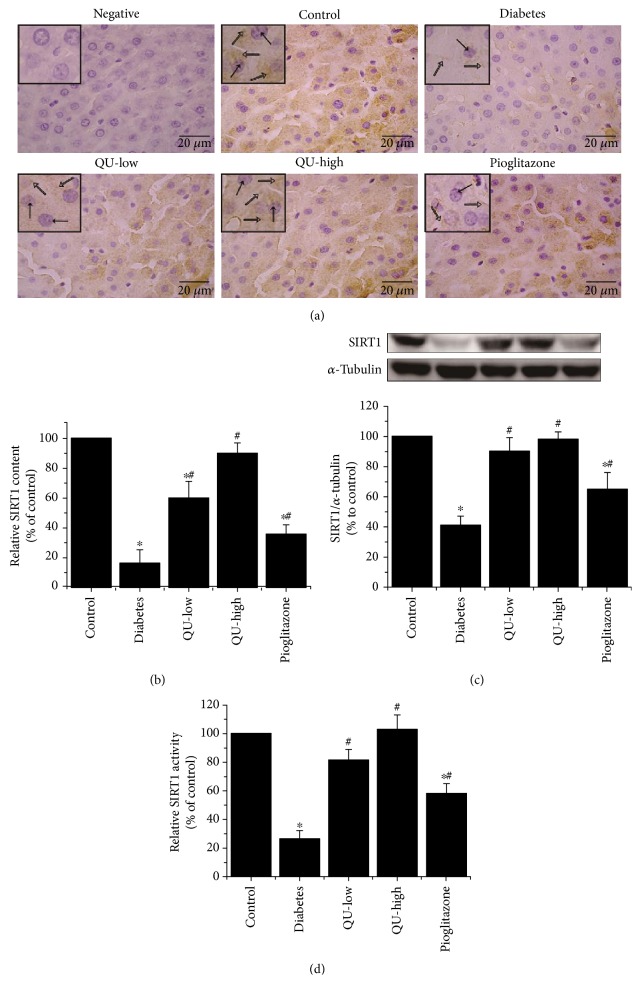
Quercetin treatment enhanced hepatic SIRT1 protein expression and deacetylase activity in STZ-induced diabetic rats. The effects of quercetin on hepatic SIRT1 expression levels in the livers of control, diabetes, QU-low, QU-high, and pioglitazone-treated rats were detected through immunohistochemistry. Staining without SIRT1 antibody was used as a negative control. (a and b) Original magnification of 400x, solid arrow indicates nuclear SIRT1, and hollow arrow corresponds to cytoplasmic SIRT1. (c) Western blot. Immunohistochemistry showed SIRT1 (dark brown) was decreased in diabetes compared with control and was partially increased by the quercetin treatment. (d) Hepatic SIRT1 deacetylase activity in rat livers was detected using a fluorometric assay kit. Data are means ± SD, n = 8. ∗P < 0.05 versus control group and #P < 0.05 versus diabetic group by ANOVA.